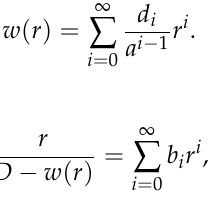
where ε 0 is the vacuum dielectric constant ( ε 0 = 8.854187817 × 10 − 12 F/m), ε r is the relative permittivity of dry air ( ε r = 1.000585), and D is the initial gap between the initial flat circular membrane and the circular conductive thin plate (suppose that D takes 35 mm here). From Equations (17) and (25) the dimensional deflection w ( r ) can be written